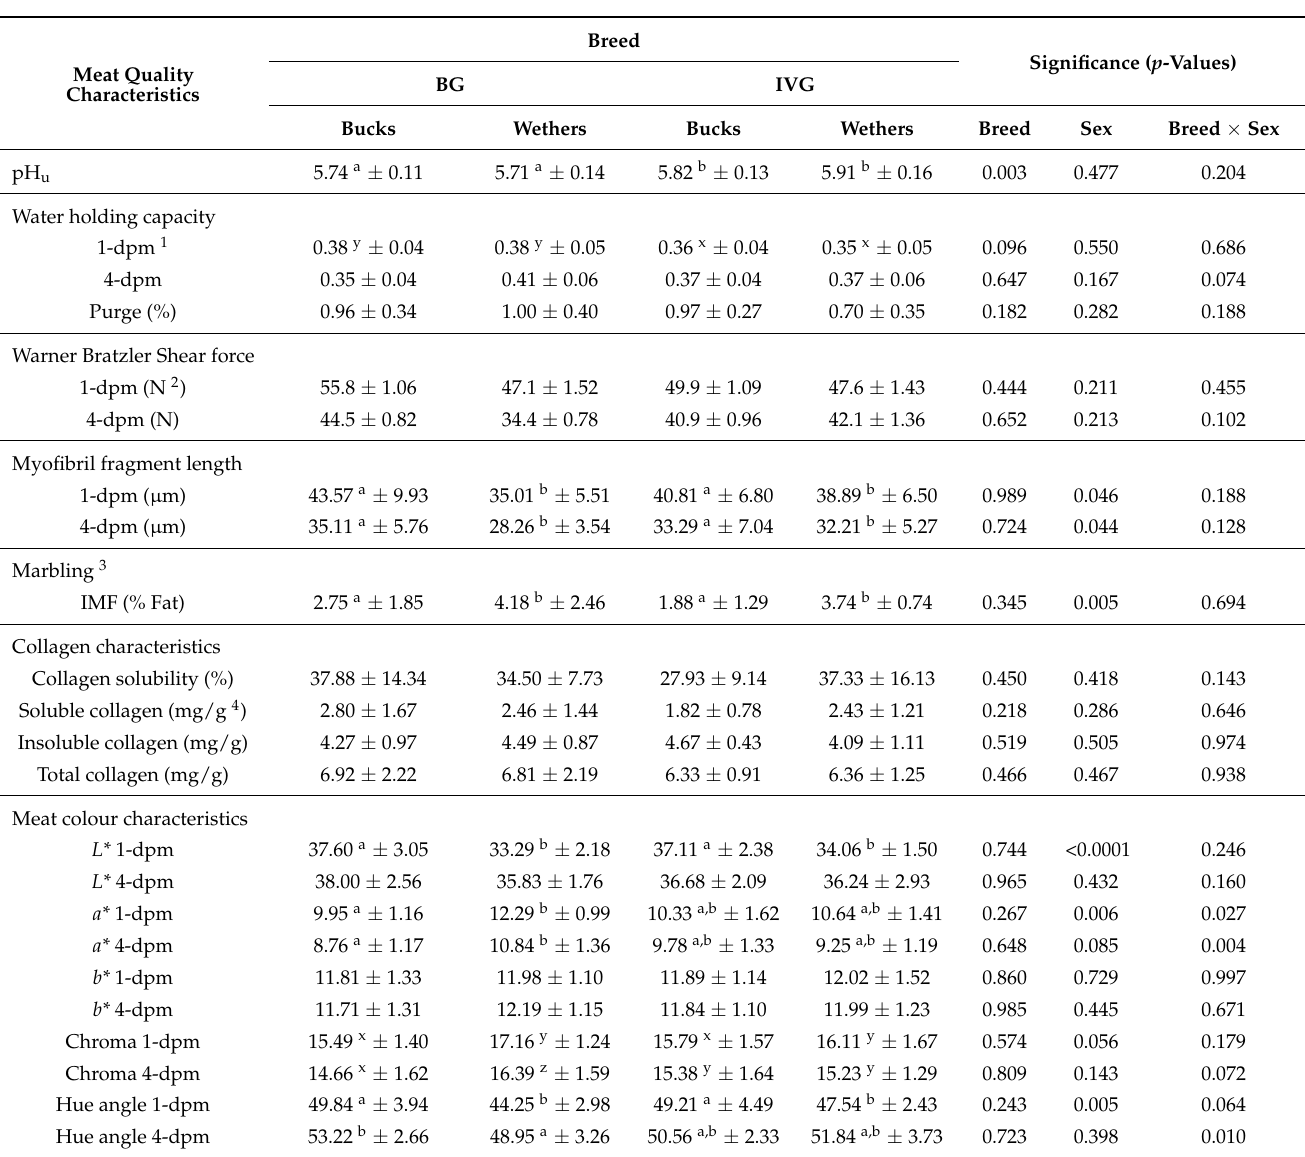
Table 4. Least square means and standard error of means for meat tenderness, meat colour and related physiological characteristics of buck and wether Boer Goats (BG) and Indigenous Veld Goats (IVG) of Biceps femoris (BF)